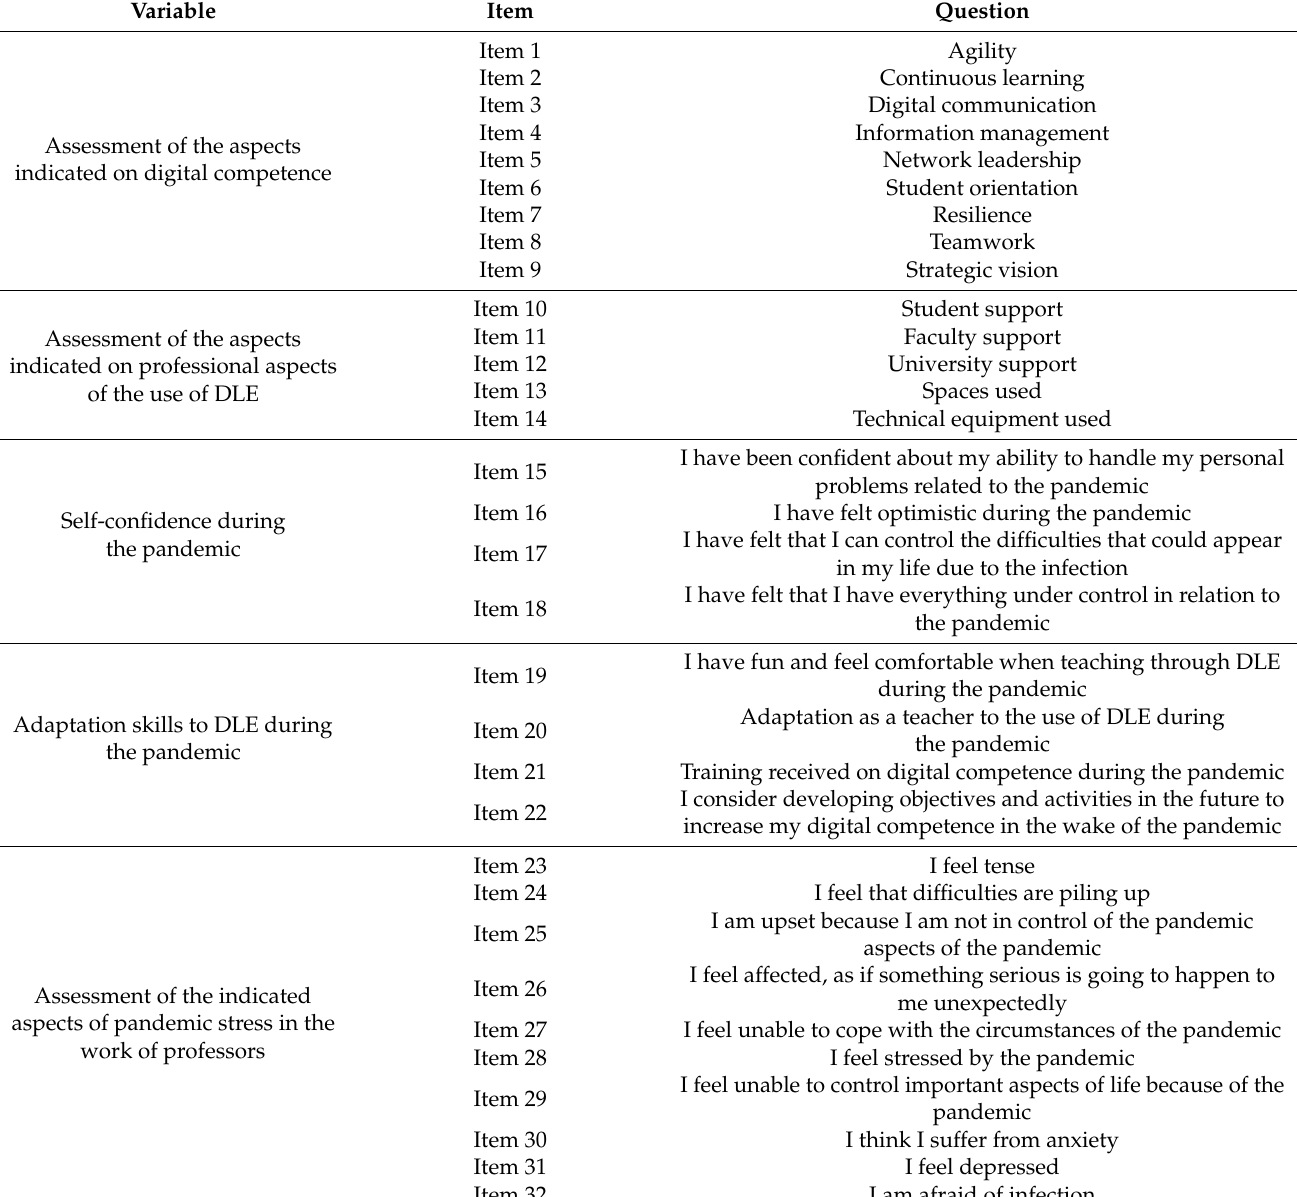
Table 1. Items of the